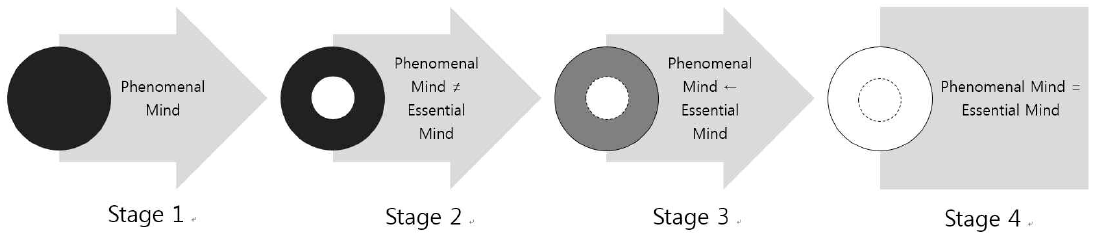
Figure 1. A process showing the stages for the explanation of the relationship between the phenomenal mind and the essential mind.